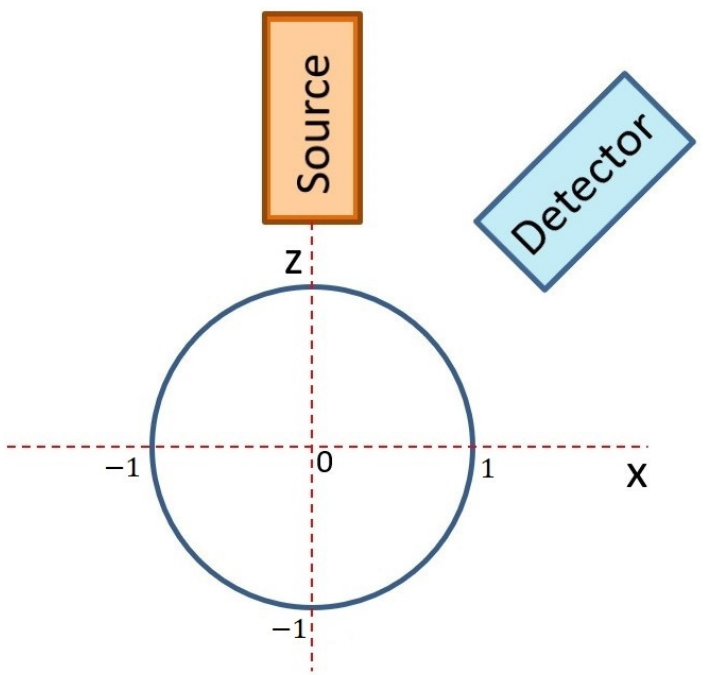
Figure 5. Scheme of Monte Carlo simulation of XRF scanning of an artifact represented by a sphere with a radius of 1 mm.